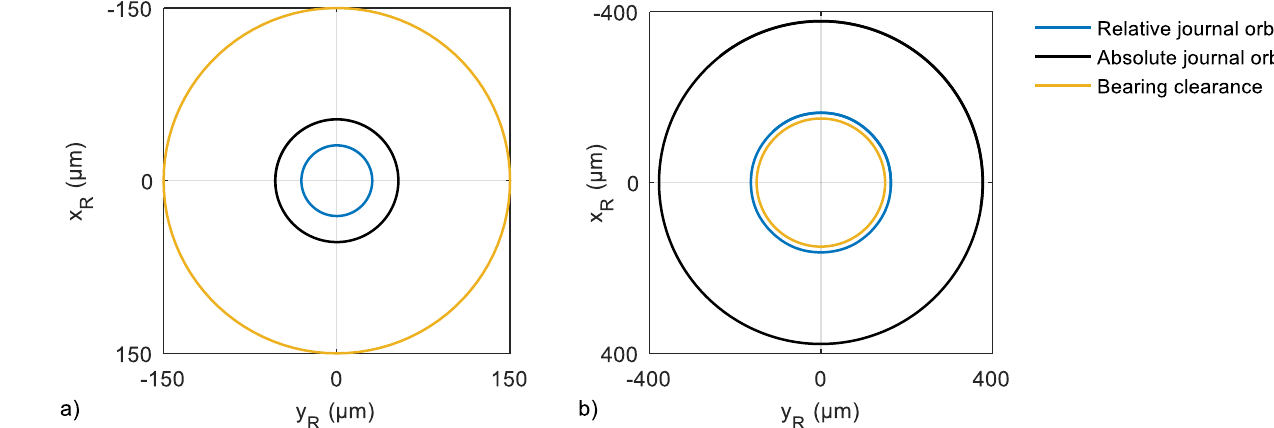
Figure 14. Absolute and relative journal orbit of the DE-bearing (NLIN), unbalance G6.3 (40%); ( a ) rotor speed n = 1500 1/min; ( b ) n = 1880 1/min, variant 1.